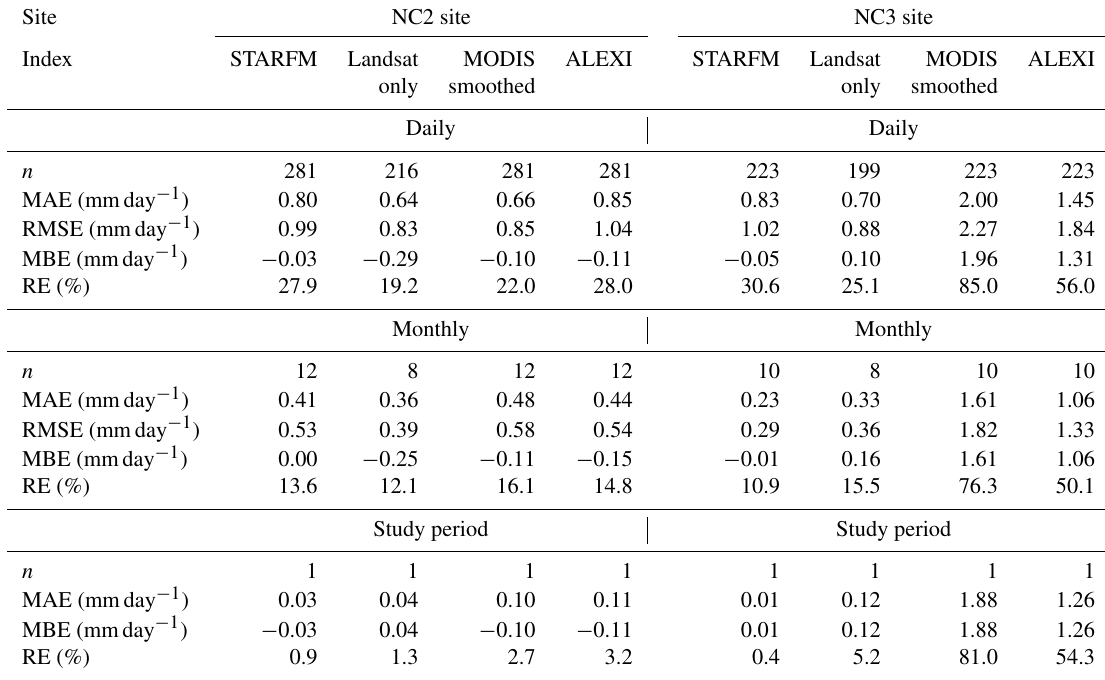
Table 3. Statistical metrics describing comparison of retrieved ET time series with tower observations at NC2 and NC3 at daily and monthly time steps, as well as cumulative values over the study period (DOY 50–330).